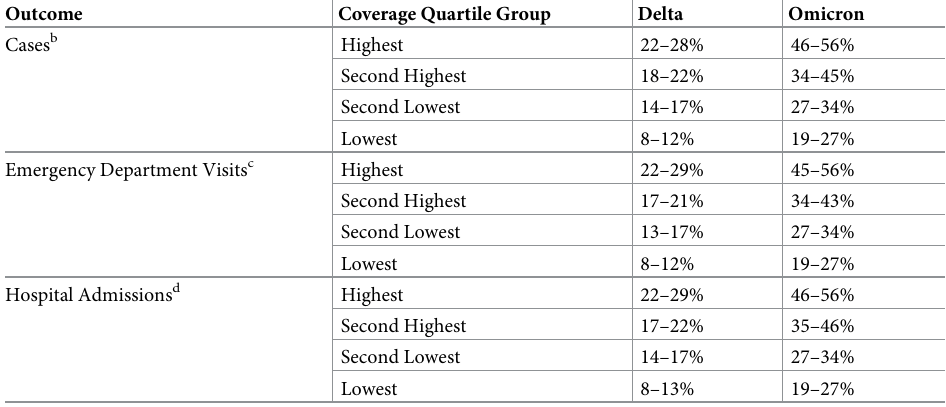
Table 1. Complete vaccination coverage ranges by state coverage quartile for midpoints a of Delta and Omicron predominant time